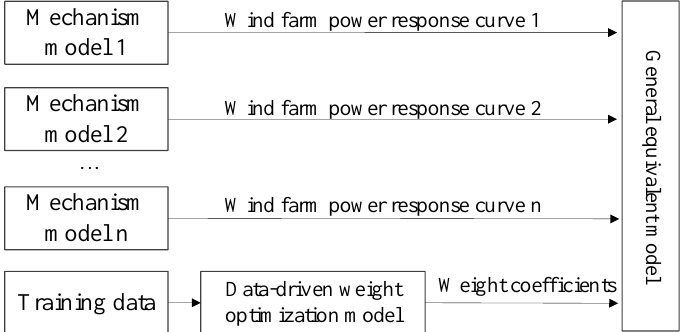
Figure 1. Framework of general equivalent modeling method.